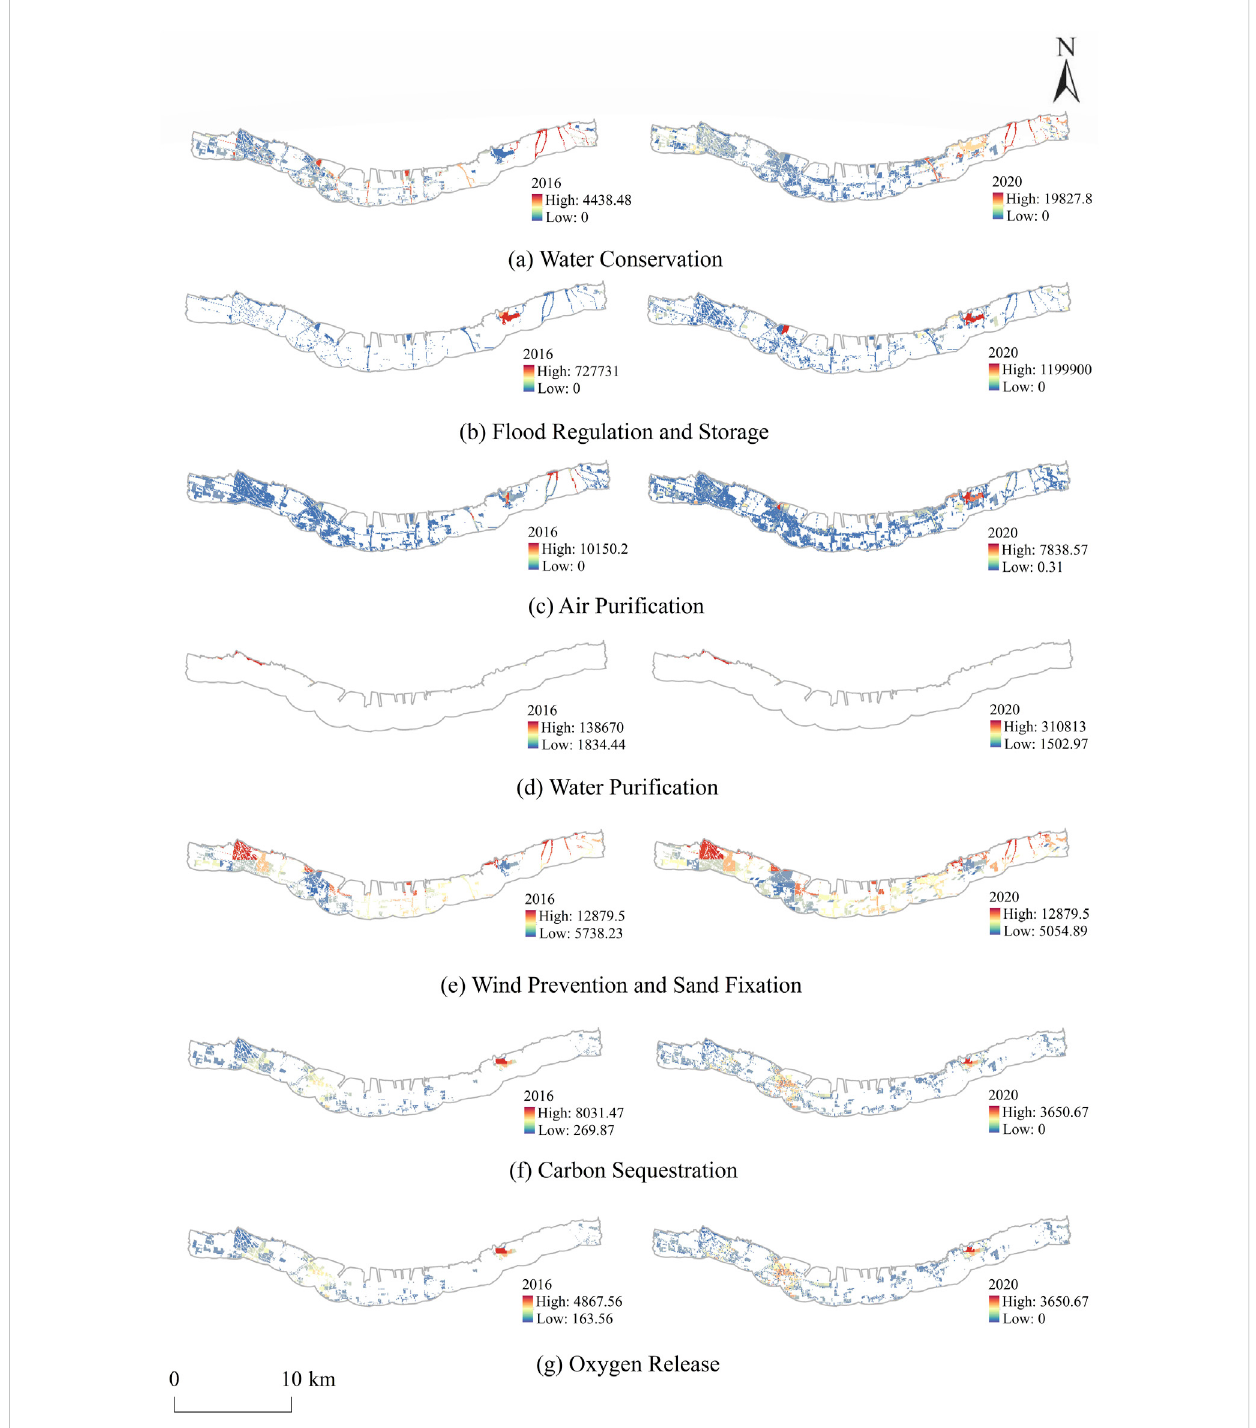
FIGURE 3 The spatial distribution of the value of regulation services in the study area in 2016 and 2020 (A – G)